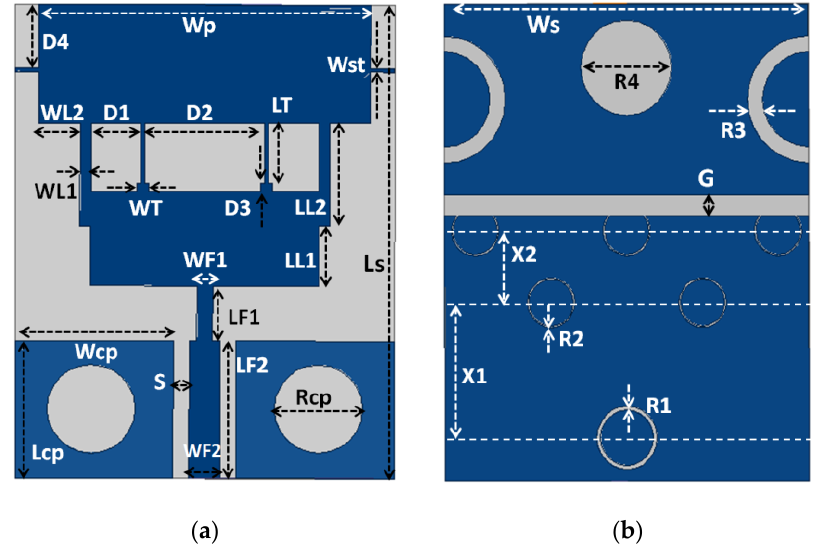
Figure5. Configurationandparametersoftheproposedmonopoleantenna( a )Frontview; ( b Figure 5. Configuration and parameters of the proposed monopole antenna ( a ) Front view; ( b ) Back view.